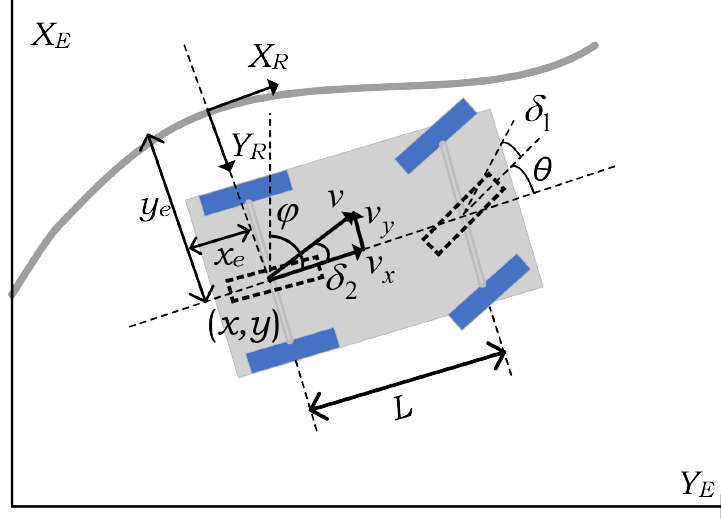
Figure 1. Reference